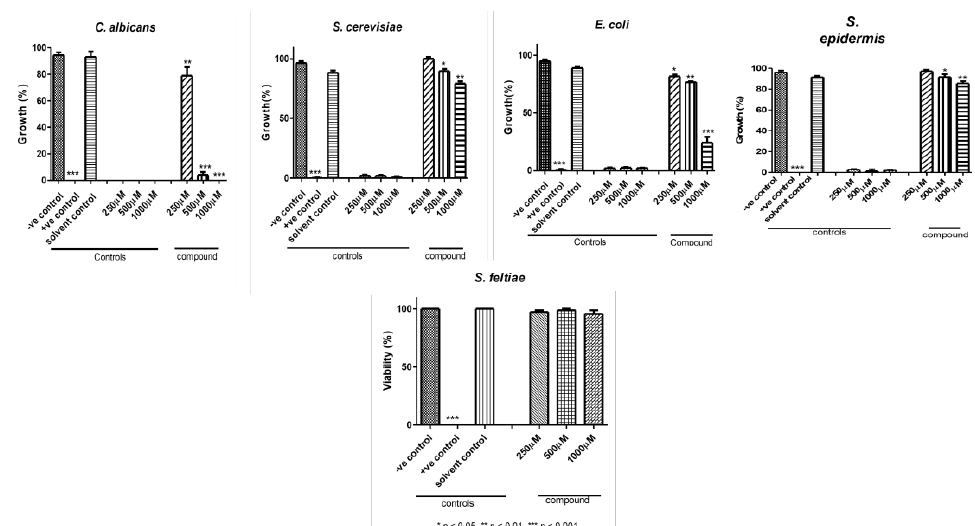
Figure 6. Antimicrobial activity of (H 2 DAB)[Co(H 2 PO 3 ) 4 ]·2H 2 O against C. albicans, S. cerevisiae, E. coli, S. epidermidis and S. feltiae .